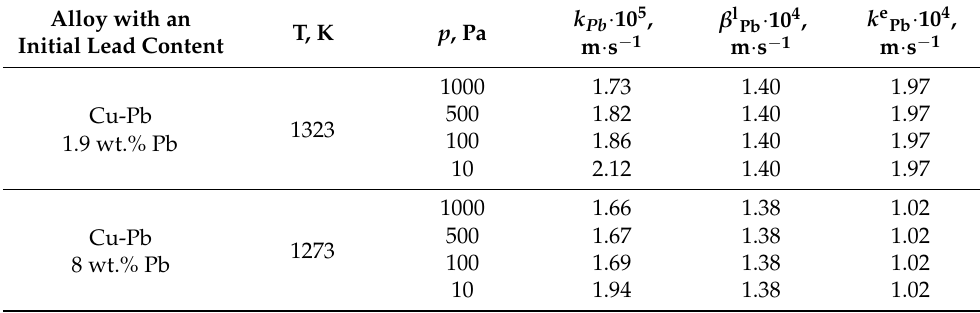
Table 7. The overall mass transfer coefficient k Pb and coefficient β l Pb and k e Pb (CCF). Alloy with